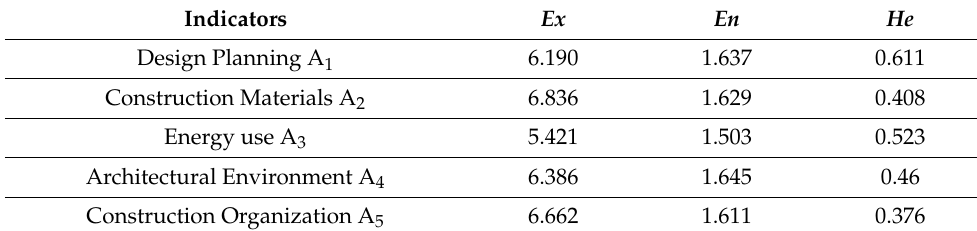
Table 7. Numerical characteristics of guideline level